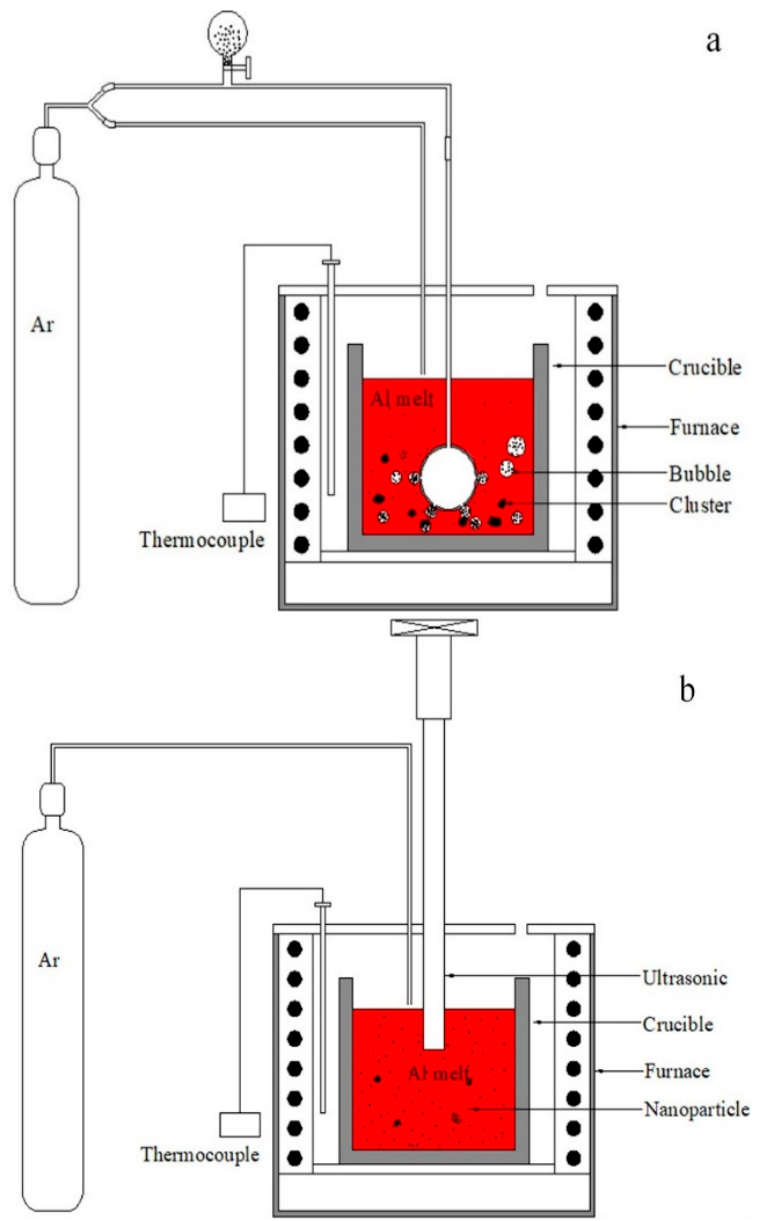
Figure 1. Schematic of the processing method for the incorporation and dispersion of nanoparticles. ( a ) Nanoparticles are blown into the Al melt by high-purity Ar; ( b ) nanoparticles are dispersed by an ultrasonic process.